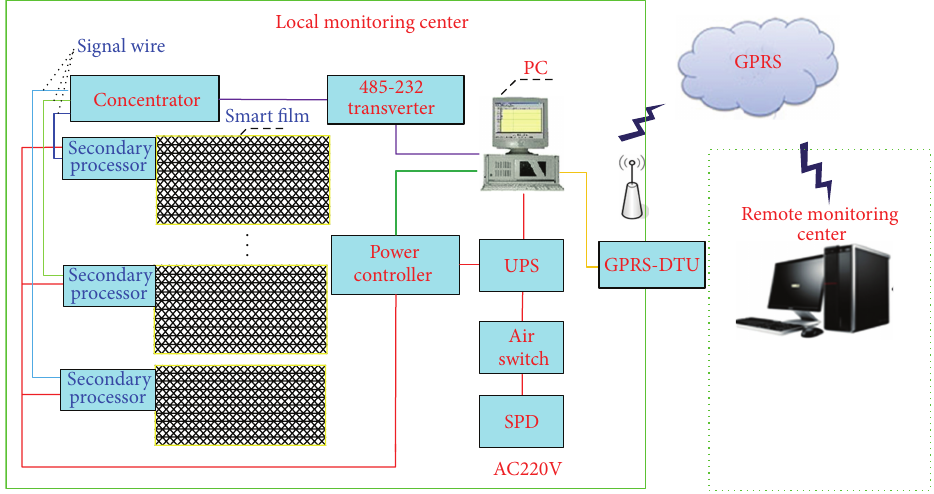
Figure 9: Hardware schematic of the remote crack monitoring system based on smart